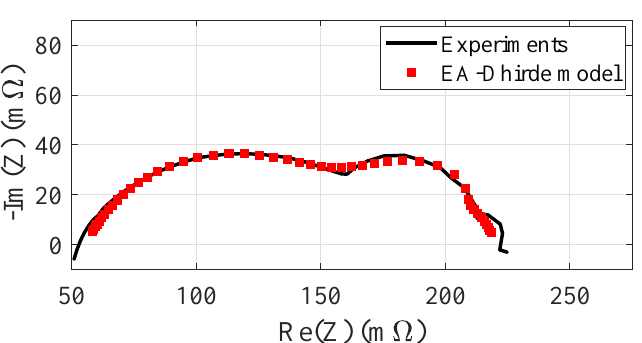
Figure 8. Dataset B. Anode drying.